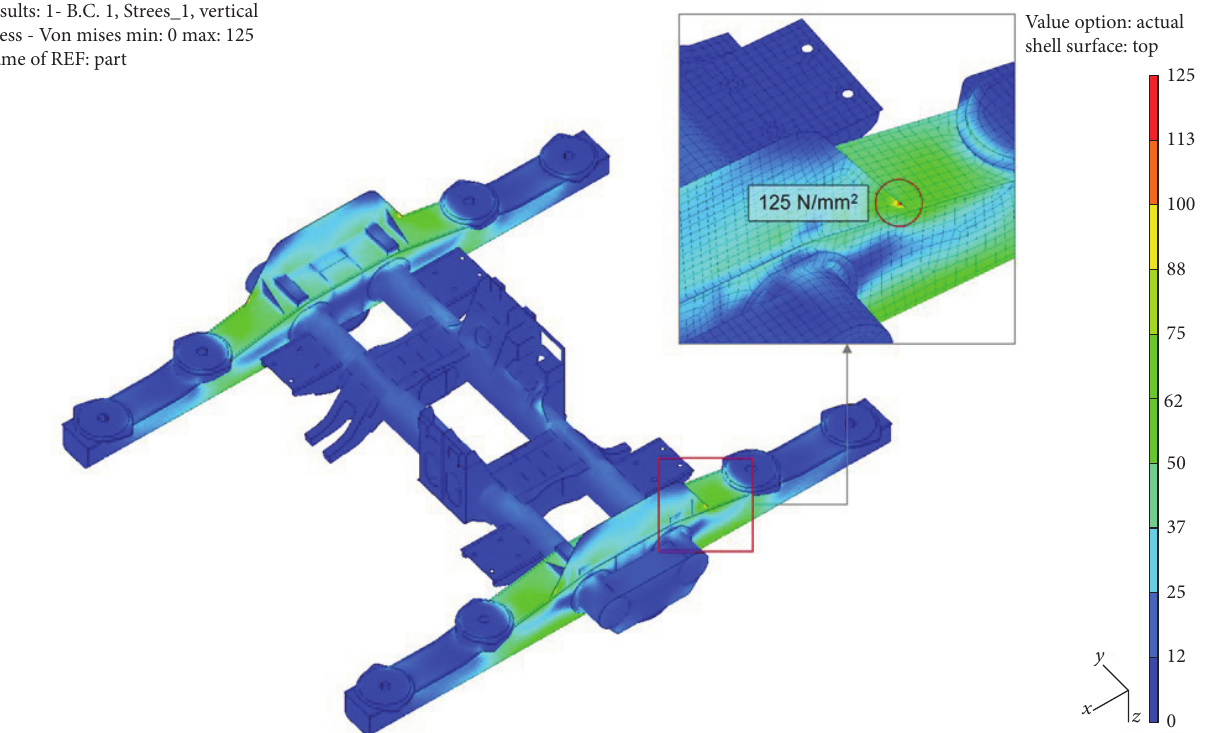
Figure 2: Maximum stress of the bogie frame under vertical Load.